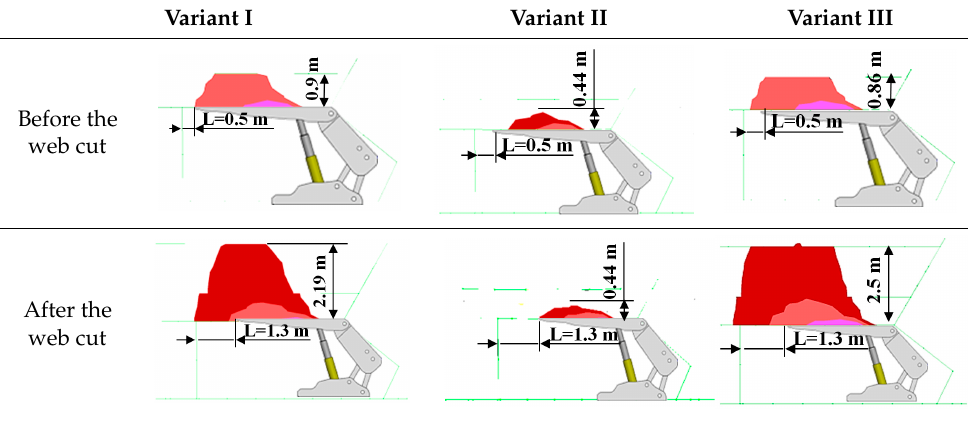
Before the web cut